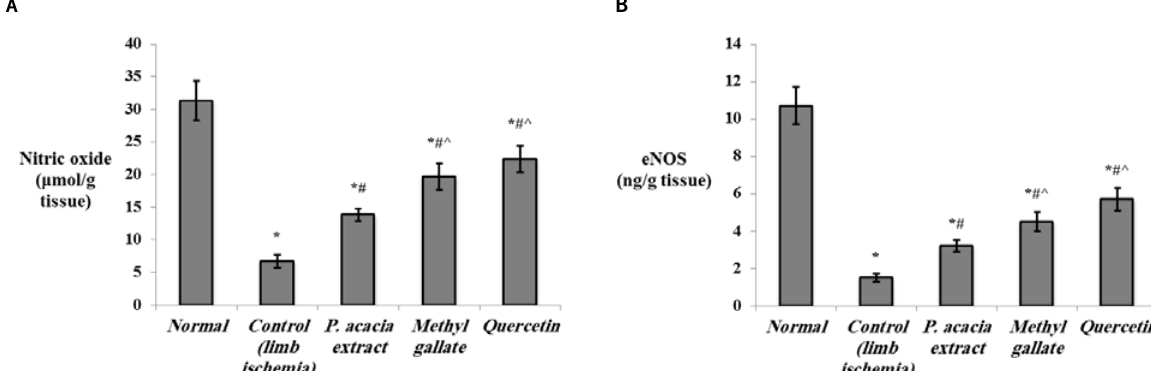
Figure 6. The effect of the P. acacia extract and its isolated compounds (methyl gallate and quercetin) on the levels of ( A ) nitric oxide, and ( B ) eNOS in the hind limb tissue of the experimental rats ( n = 8). eNOS = endothelial nitric oxide synthase. Data are expressed as the mean ± SD and were analyzed using one-way ANOVA followed by Bonferroni’s post hoc test. * Significantly different compared to the normal group, # significantly different compared to the hind limb ischemia control group, ˆ significantly different compared to the group treated with the P. acacia extract. Values were considered significantly different at p < 0.05.